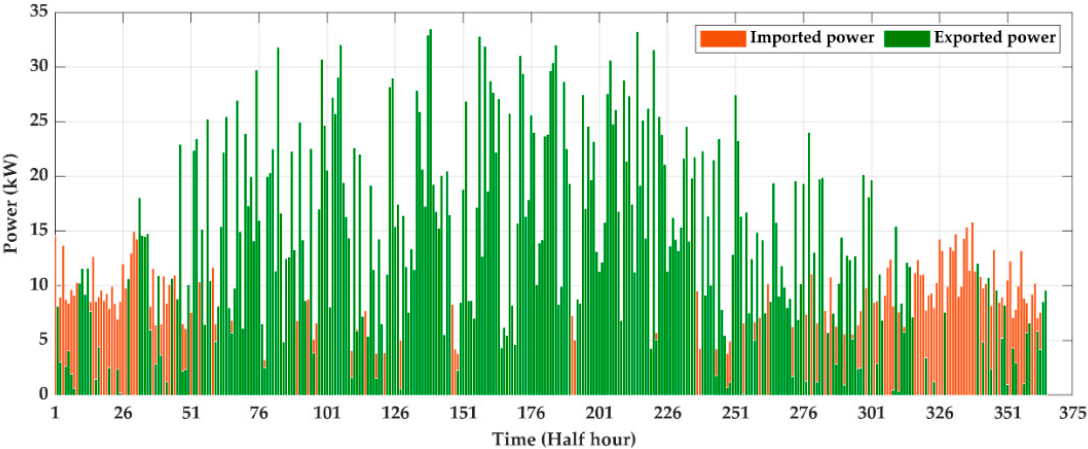
Figure 8. Imported and exported power with a PV system, grid, and BSS.